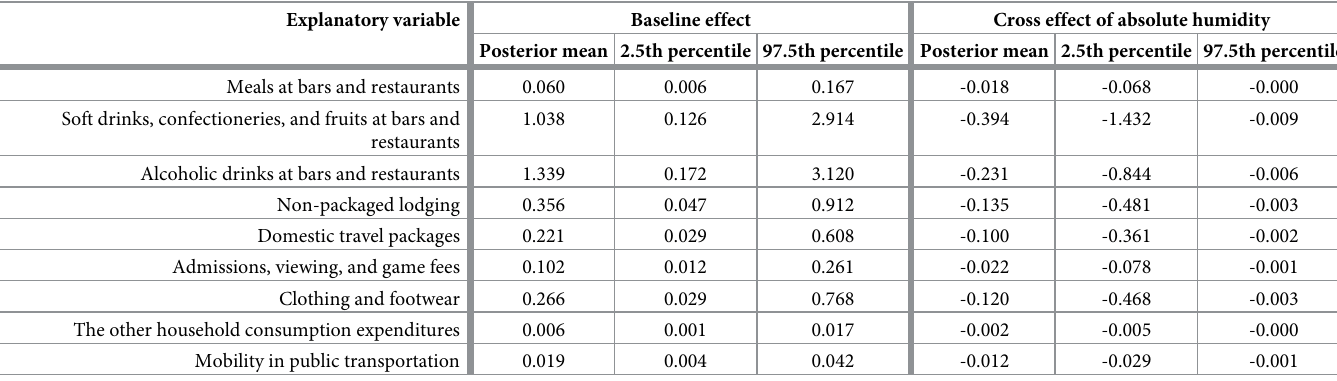
Table 2. Estimated regression coefficients of classified components of household expenditures and mobility in public transportation in